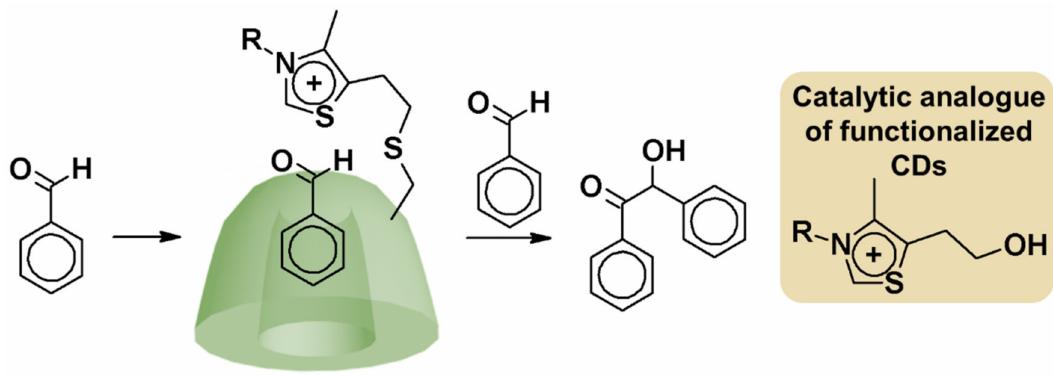
Figure 4. Benzoin condensation catalyzed by thiazolium-functionalized β - and γ -CD (R = Et or